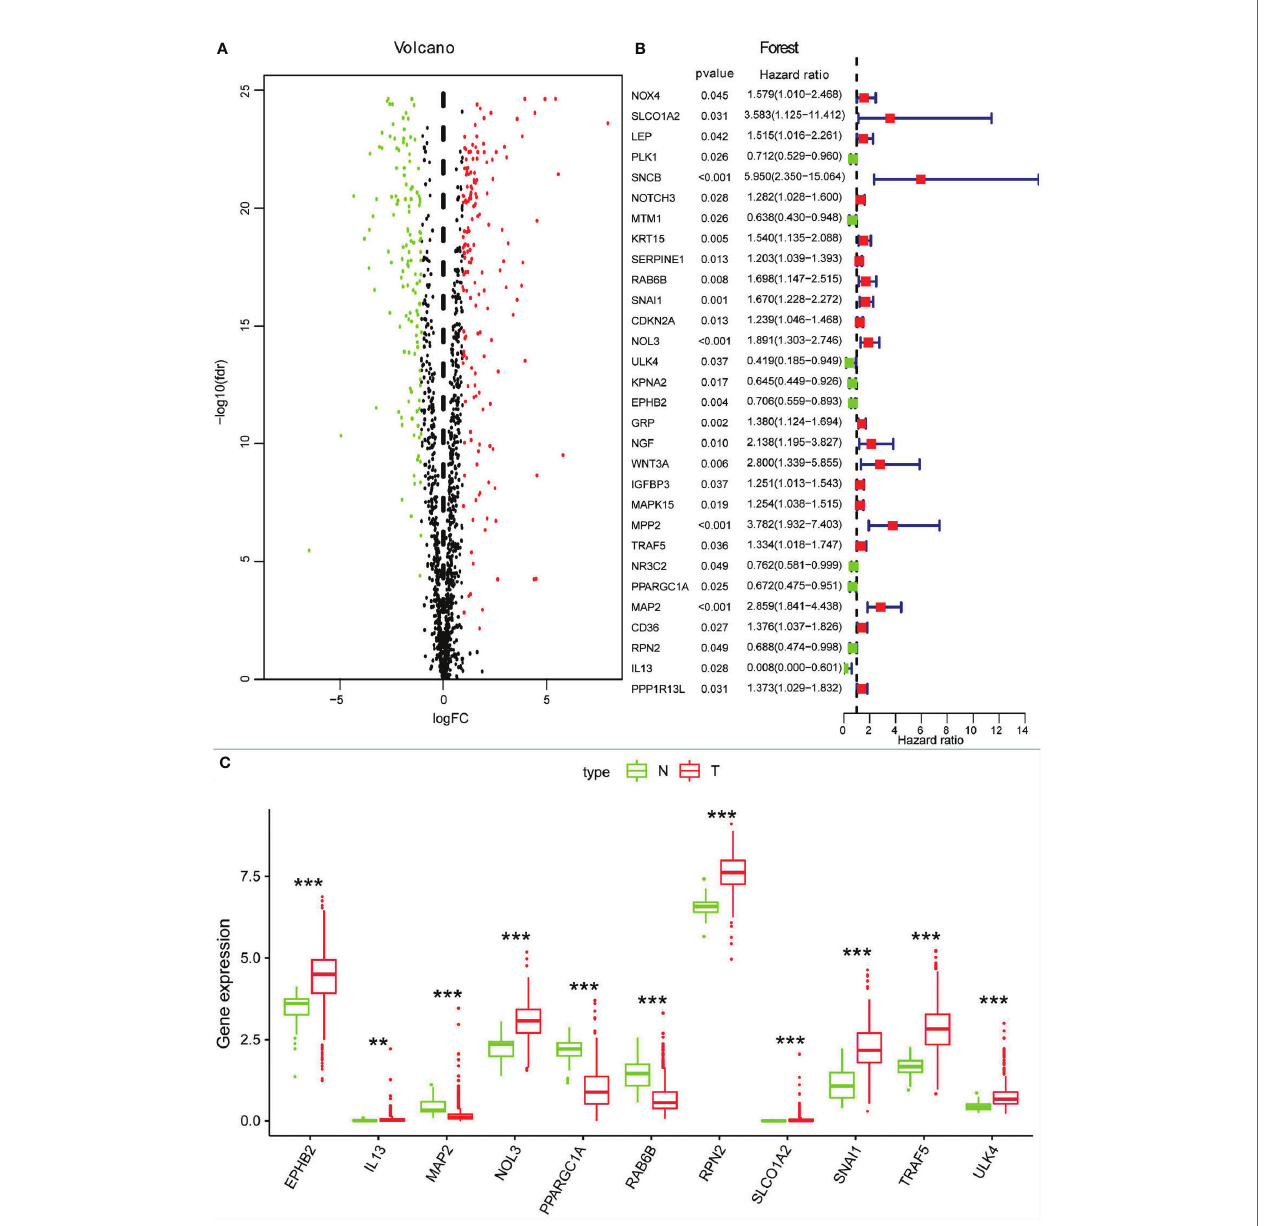
FIGURE 1 | (A) Volcano map of autophagy-associated DEGs. (B) Screening of autophagy-associated genes associated with the prognosis of CRC by univariate Cox analysis. (C) Box plot showing expression of 11 autophagy-associated genes in normal tissues and CRC. ** p < 0.01, *** p <